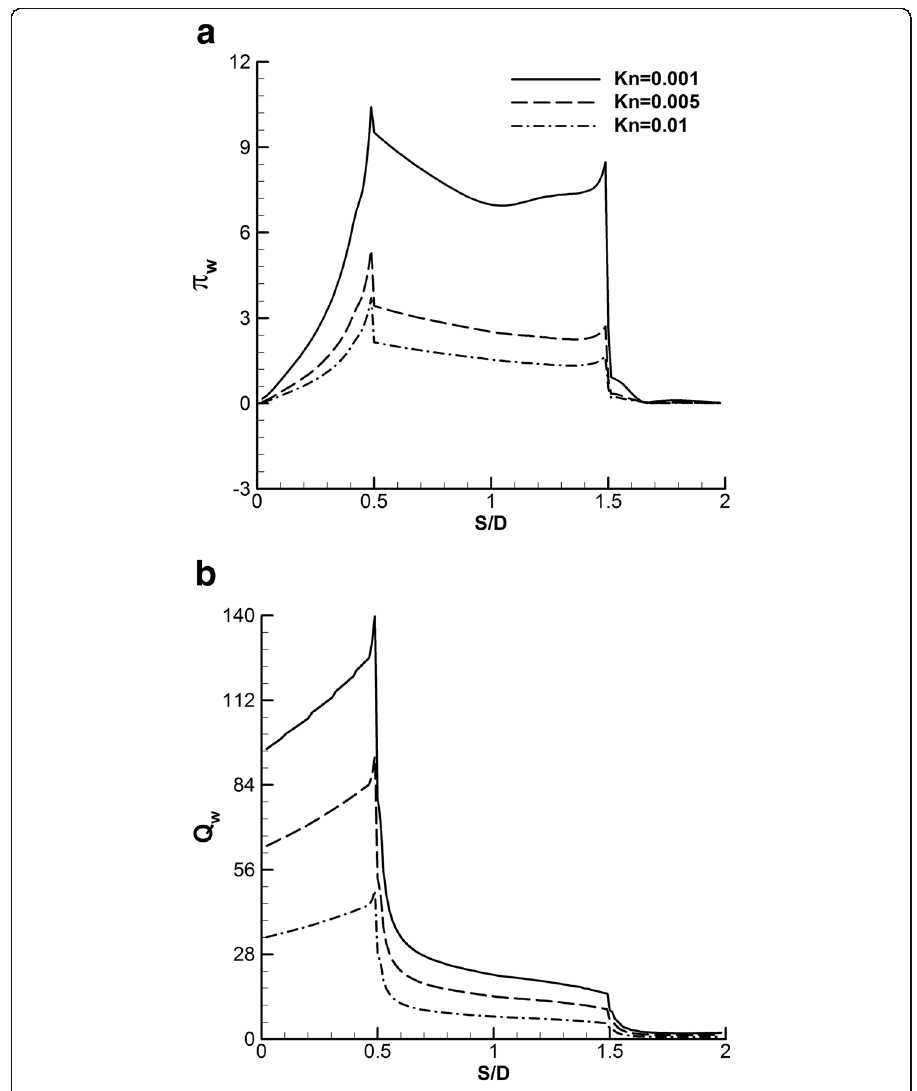
Fig. 10 Comparison of normalized quantities measured on the surface of the square cylinder for different Knudsen numbers (0.001, 0.005, and 0.01) at M = 6: a shear stress, and b heat